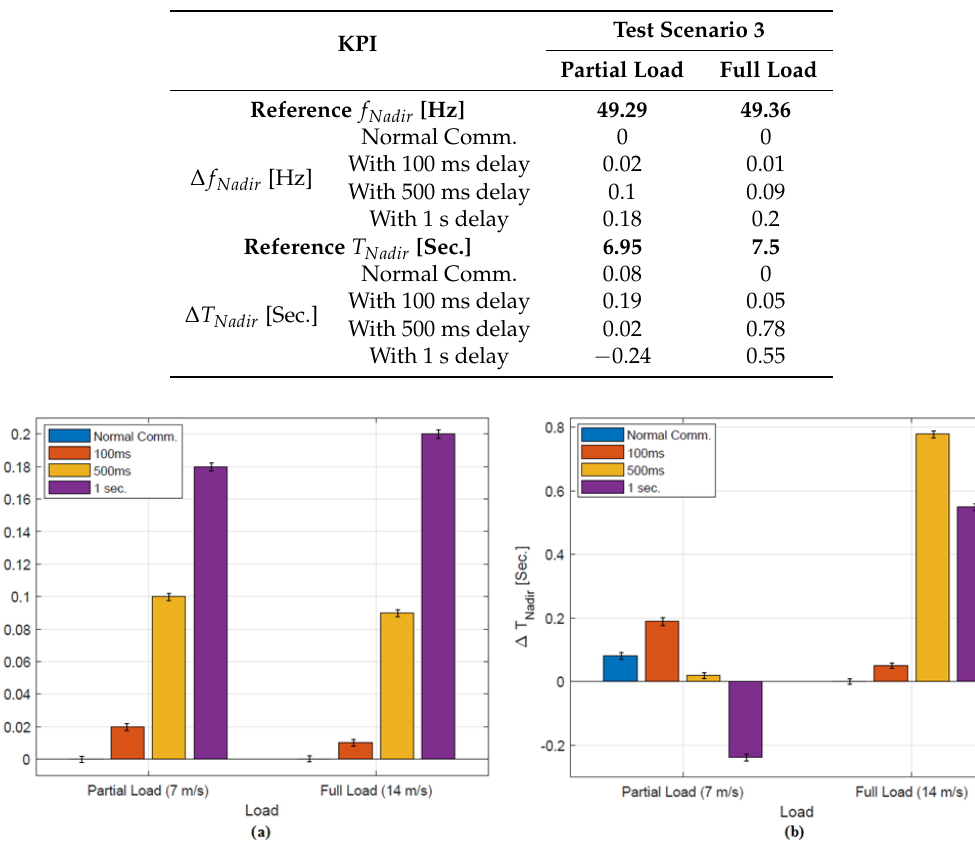
Figure 17. Comparison of ( a ) f Nadir and ( b ) T Nadir obtained in Test Scenario -3 with that of Reference Frequency Response at 95% Confidence